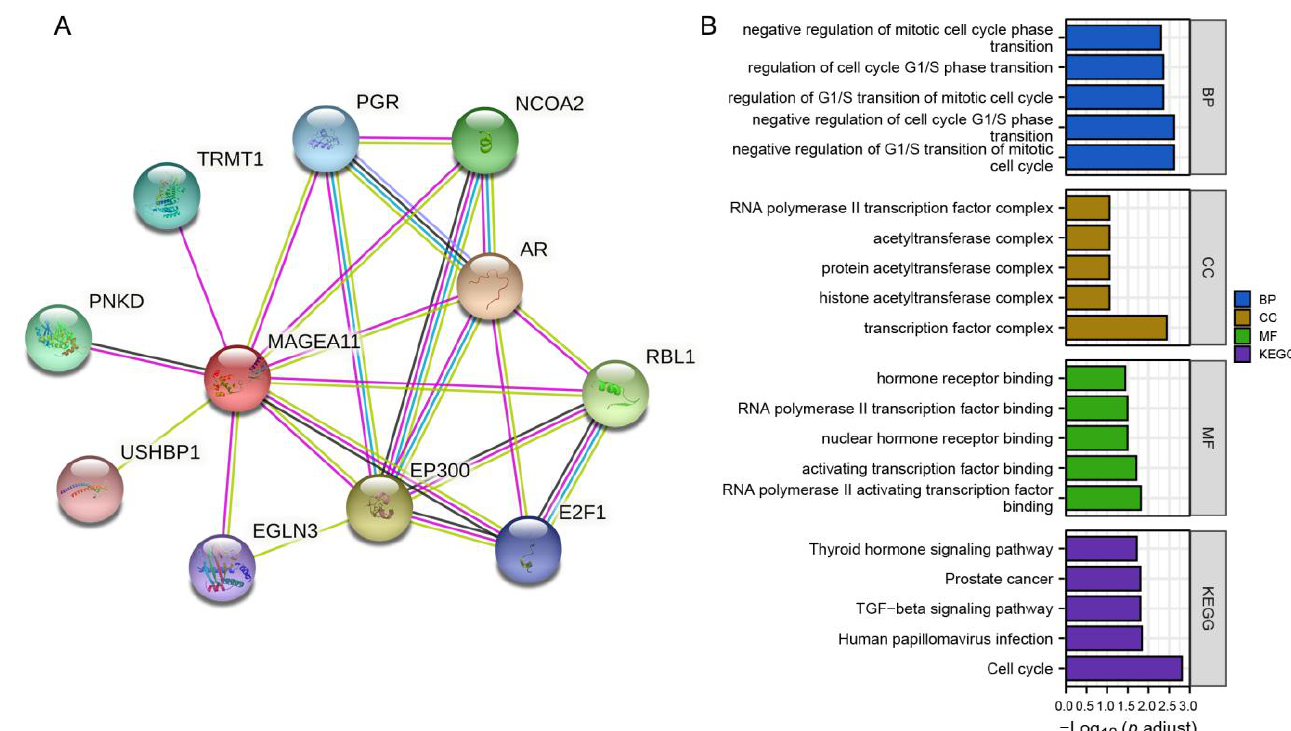
Figure 5. PPI network and feature enrichment analysis. ( A ) MAGEA11 and its interacting gene net- network. ( B ) Functional enrichment analysis of interacting work. ( B ) Functional enrichment analysis of interacting genes.